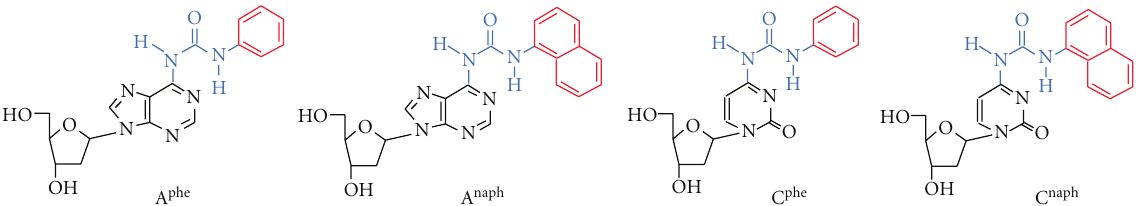
Figure 3: Structures of the base pair-mimic nucleosides of deoxyadenosine and deoxycytidine derivatives tethering the nonpolar aromatic group (colored in red) through an ureido linker